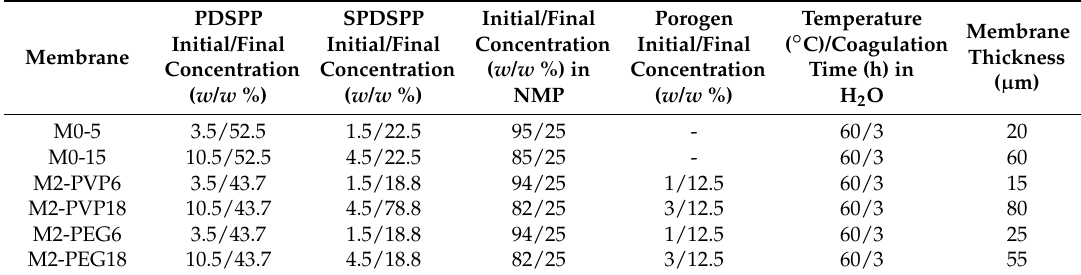
Table 3. Preparation of membranes with 70/30 w / w PDSPP/SPDSPP in NMP at 5% or 15% w / w , addition of PVP or PEG at 12.5% w / w final concentration, casting at 80 ◦ C until 75% w / w total final polymers’ concentration and immersion in H 2 O at 60 ◦ C for 3